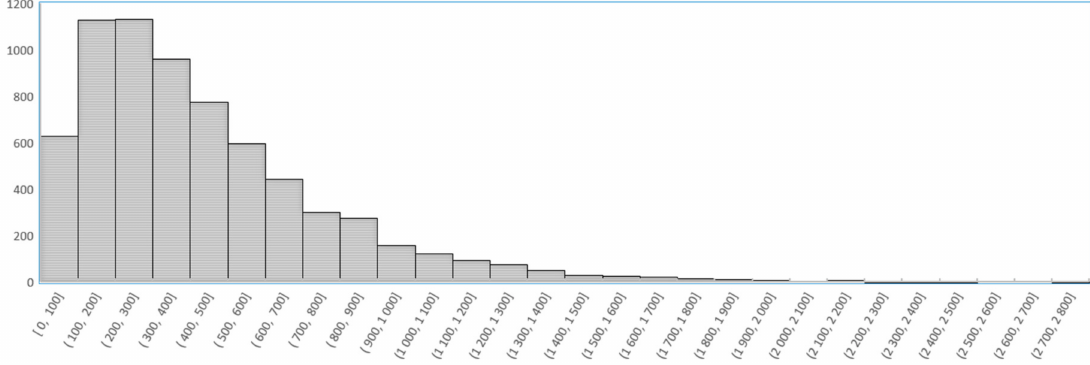
Figure 4. Histogram of distribution of deviations (in meters) on GCPs after the adjustment (polynomial, IRLS).